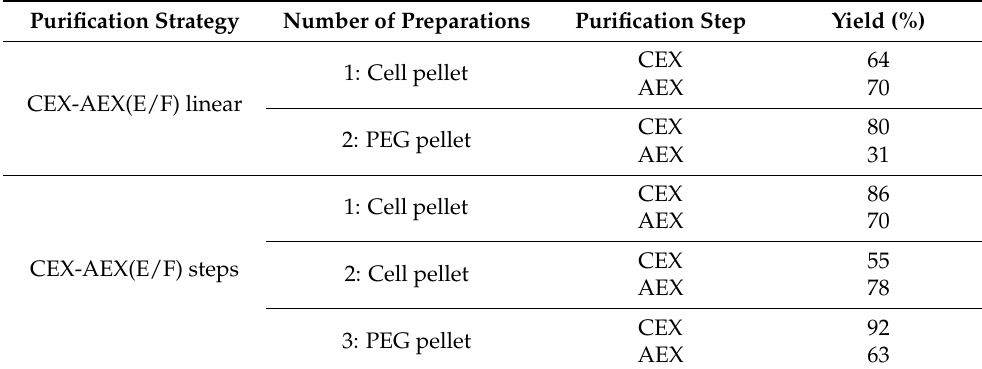
Table 3. Remaining percentage of the original vg amount of rAAV after each different purification step. Purification Strategy Number of Preparations Purification Step Yield (%) CEX 64 1: Cell pellet AEX 70 CEX-AEX(E/F) linear CEX 80 2: PEG pellet AEX 31 CEX 86 1: Cell pellet AEX 70 CEX-AEX(E/F) steps 2: Cell pellet